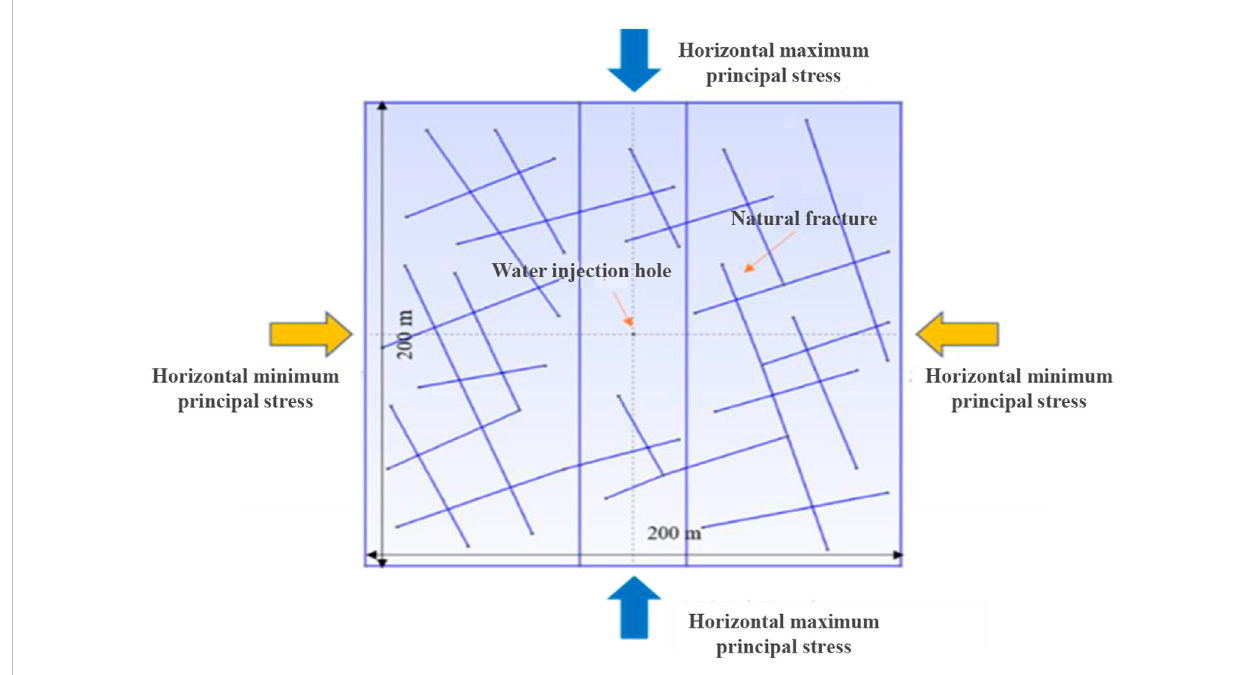
FIGURE 5 Multi-stage temporary plugging acid fracturing model for fractured reservoir.